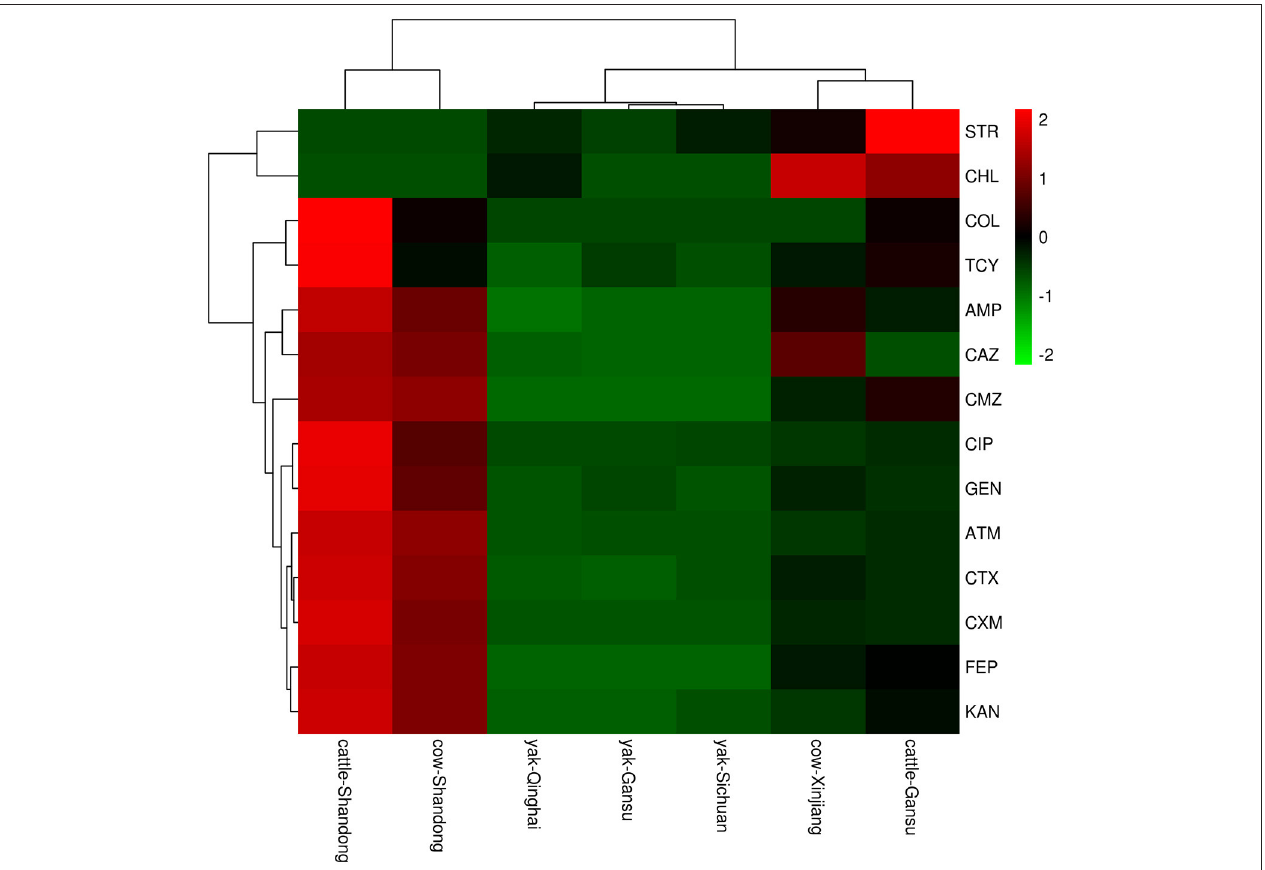
FIGURE 2 | A heatmap of resistant phenotype percentage of E.coli isolation from different areas. The right side of the legend shows the color range of different R values. Species clustering trees are presented on the left side of the heat map.